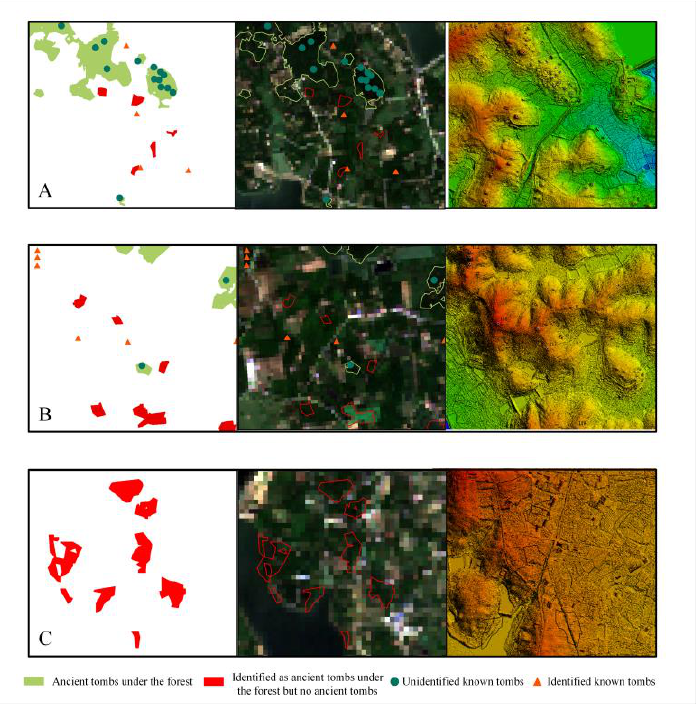
Figure 16. Identify areas with errors in results. ( A ) It is the area with better identification results. ( B ) It is the area with the average identification results. ( C )It is the area with poor identification